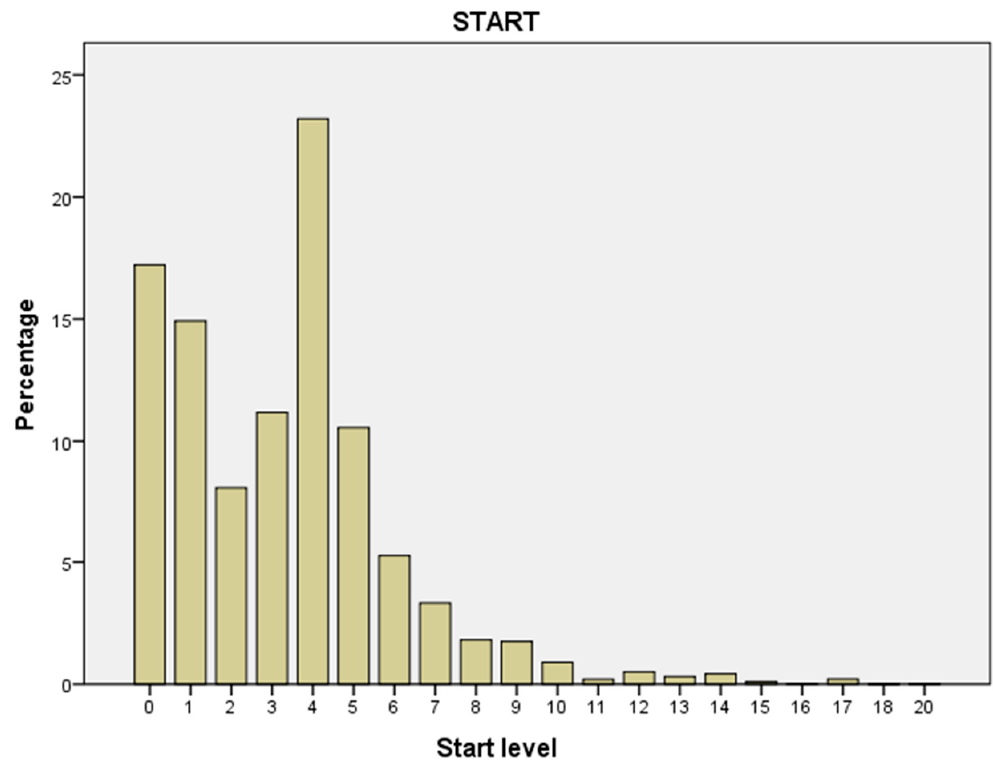
Mathematics 2018 , 6 , x Figure 1. Percentage of students in each start level (START).